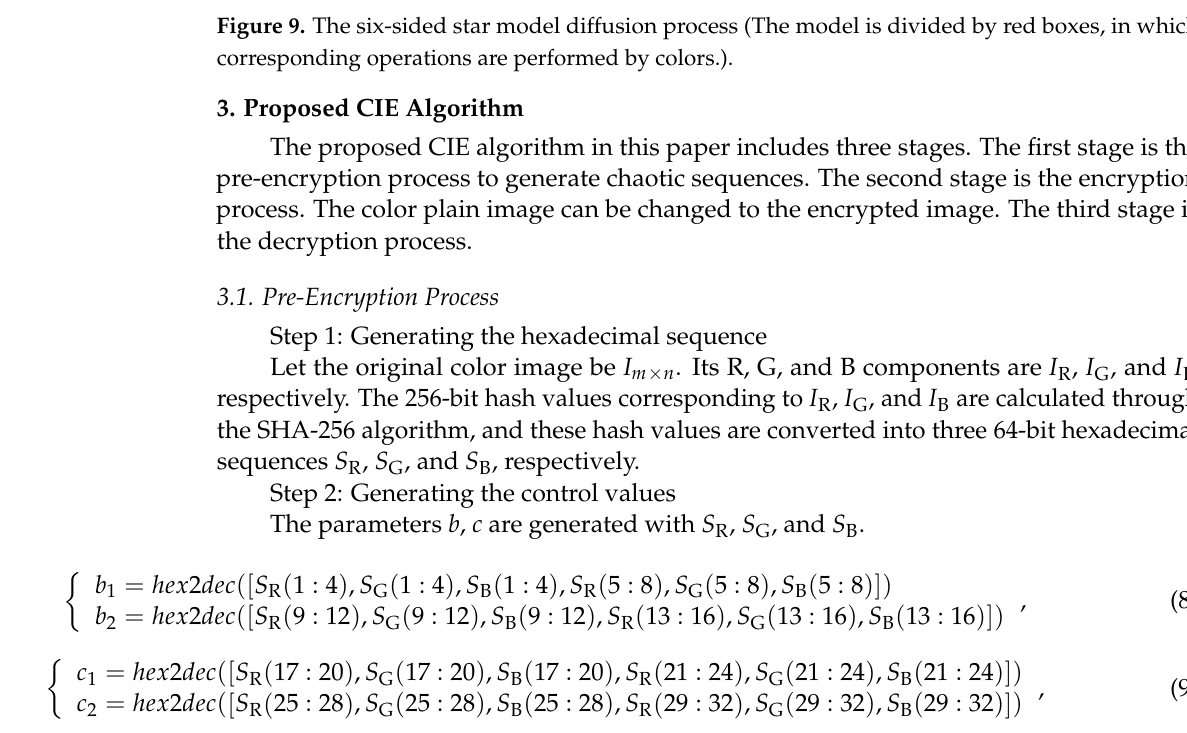
Figure 9. The six-sided star model diffusion process (The model is divided by red boxes, in which corresponding operations are performed by colors.).